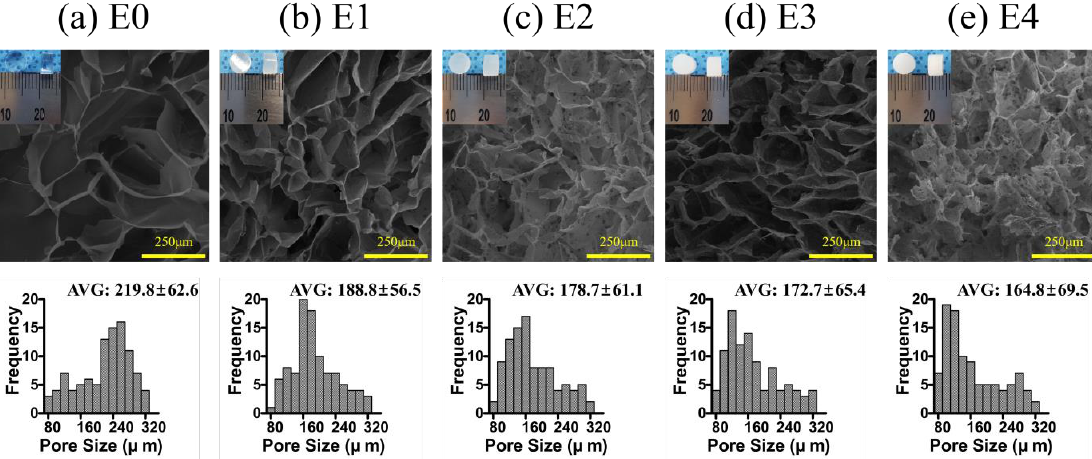
Figure 6. Cross-sectional SEM images and histograms representing the pore size distributions of E0 ( a ), E1 ( b ), E2 ( c ), E3 ( d ), and E4 ( e ). One hundred measurements were made to provide the pore size distribution for each sample.